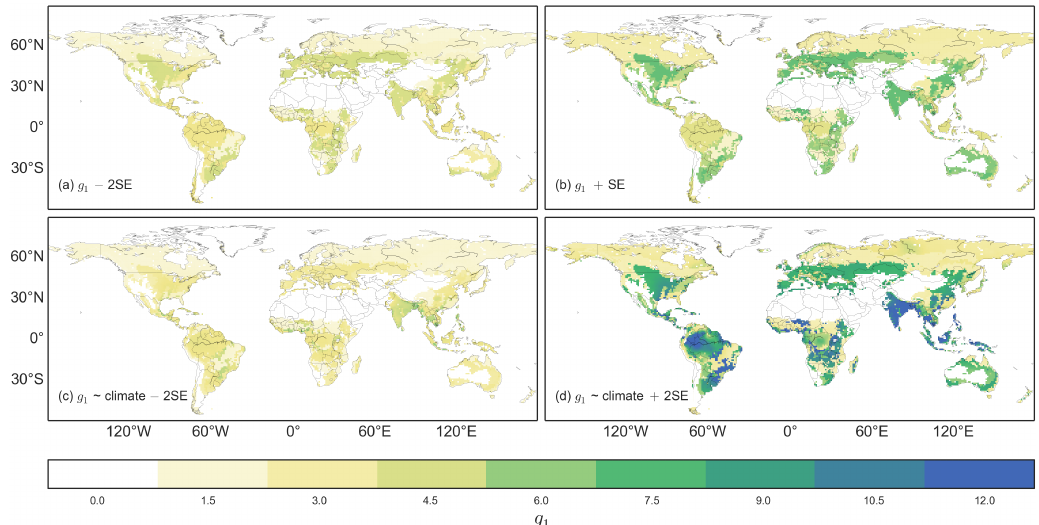
Figure A1. Global maps showing the uncertainty of the g 1 model parameter. Panel (a) shows − 2 standard errors (SE) and (b) + 2 SE for the fitted g 1 for each of CABLE’s PFTs. Panel (c) shows − 2 standard errors (SE) and (e) + 2 SE for predicted g 1 parameter values considering the influence of climate indices. In total, 126 out of a possible 54000 pixels have been masked from panels (c) and (d) , representing pixels where the temperature range and moisture index extended outside the range of the synthesis g s database. Figure S2